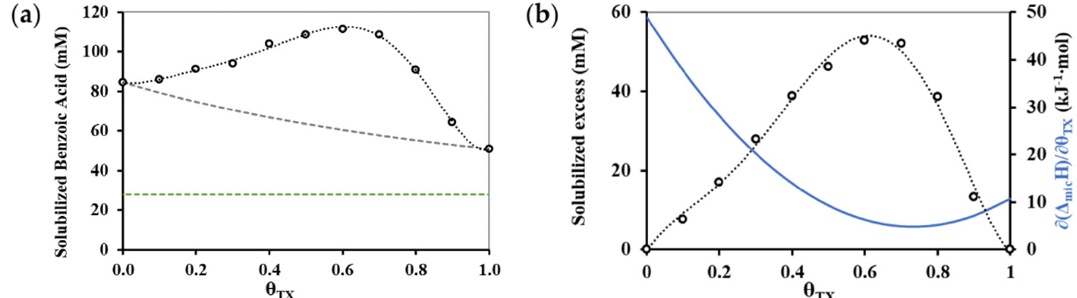
Figure 6. ( a ) Mixed ( θ TX = 0.2; 0.4; 0.6 and 0.8) and pure ( θ TX = 0.0 and 1.0) micelles solubilized amount of benzoic acid at 298 K as a function of bulk phase composition (dashed grey line indicates the ideal behavior suggested [29] solubilized amount, while dashed green line indicates the solubility of benzoic acid in water); ( b ) Change of solubilized excess (calculated from the experimental and predicted solubilized amount of benzoic acid) and the first derivative of the enthalpy change of micelle formation ( ∂ ( Δ mic H )/ ∂ θ TX ) against the bulk phase composition at 298 K.